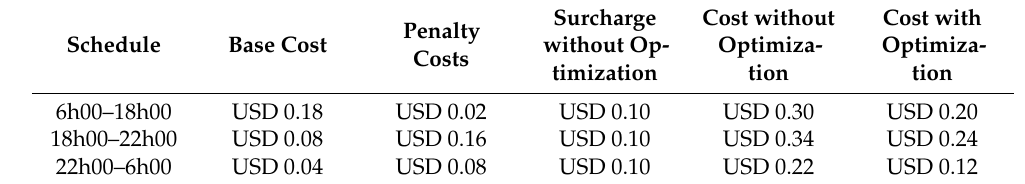
Table 8. Costs for recharging electrical energy with and without optimization.